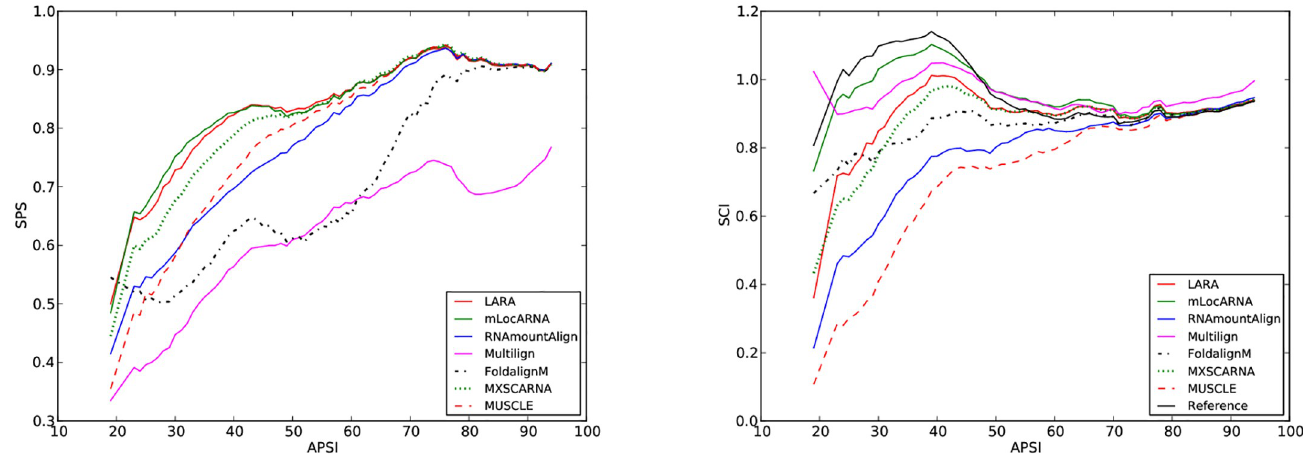
Fig 7. Sum-of-pairs (SPS) score (left) and structural conservation index (SCI) (right) for multiple global alignments using RNAmountAlign , LARA , mLocARNA , FoldalignM , Multilign , MXSCARNA and MUSCLE . SPS and SCI are shown as a function of average pairwise sequence identity(APSI). The k5 BRAliBase 2.1 database was used for benchmarking. Moving averages taken for centered, symmetric windows of size 11.